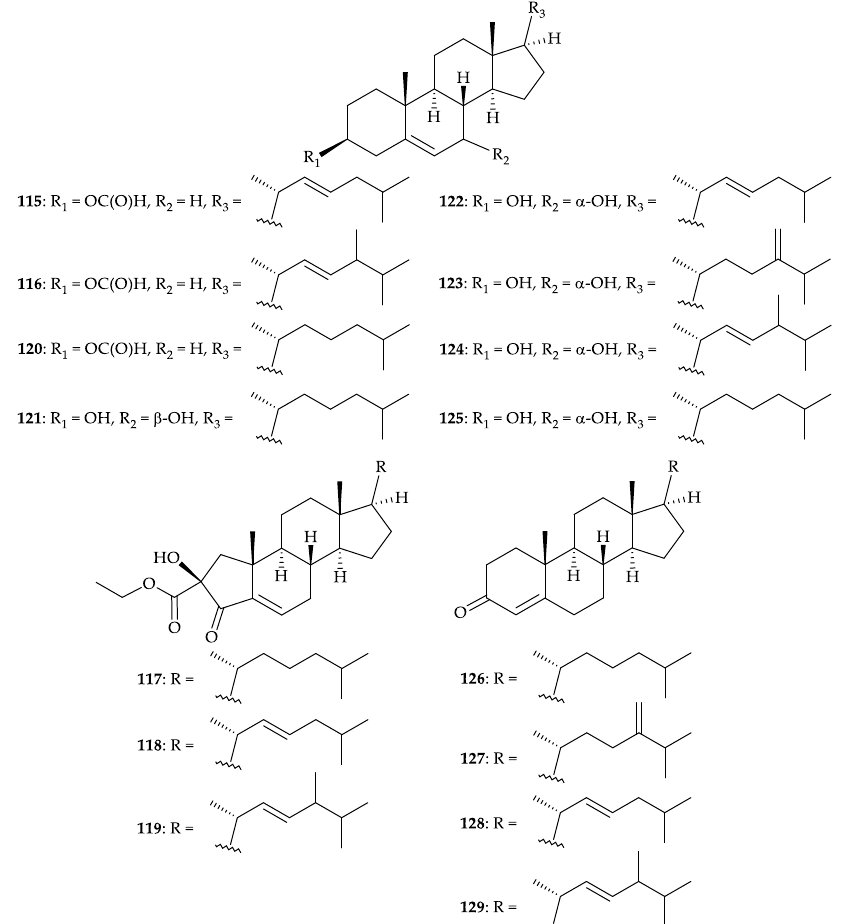
Figure 21. Structures of (22 E )-3- O -β-formylcholest-5,22-diene ( 115 ), (22 E )-3- O -β-formyl-24-methyl- cholest-5,22-diene ( 116 ), 2-ethoxycarbonyl-2-β-hydroxy-A-nor-cholest-5-ene-4-one ( 117 ), (22 E )-2- ethoxycarbonyl-2-β-hydroxy-A-nor-cholest-5,22-diene-4-one ( 118 ), (22 E )-2-ethoxycarbonyl-2-β- hydroxy-24-methyl-A-nor-cholest-5,22-diene-4-one ( 119 ), 3-β-formyloxycholest-5-ene ( 120 ), 3β,7β- dihydroxycholest-5-ene ( 121 ), (22 E )-3β,7α-dihydroxy-cholest-5,22-diene ( 122 ), 3β,7α-dihydroxy-24- methylene-cholest-5-ene ( 123 ), 3β,7α-dihydroxy-24-methyl-cholest-5,22-diene ( 124 ), 3β,7α- dihydroxy-cholest-5-ene ( 125 ), cholest-4-ene-3-one ( 126 ), 24-methylene-cholest-4-ene-3-one ( 127 ), (22 E )-cholest-4,22-dien-3-one ( 128 ), and (22 E )-24-methyl-cholest-4,22-dien-3-one ( 129 ).